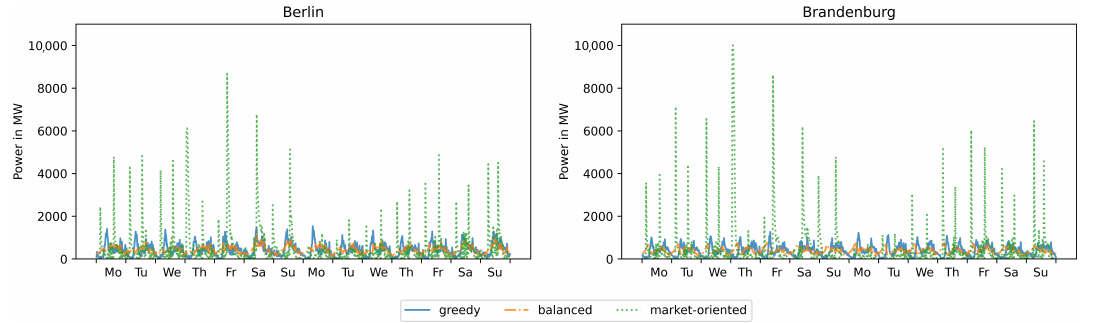
Figure 4. Total load profile for each charging strategy for Berlin and Brandenburg for 2